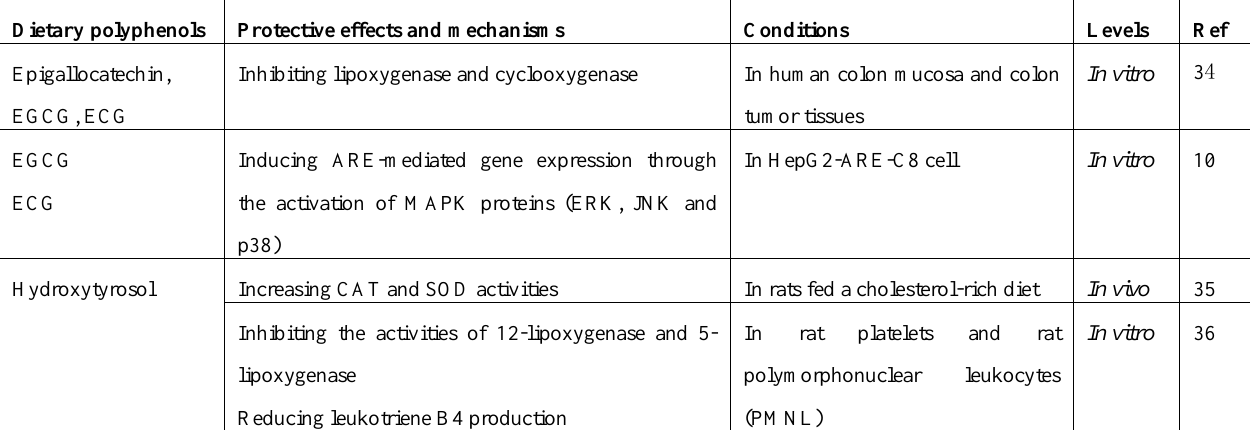
Table 2. Antioxidant and free radical scavenging properties of dietary polyphenols. Dietary